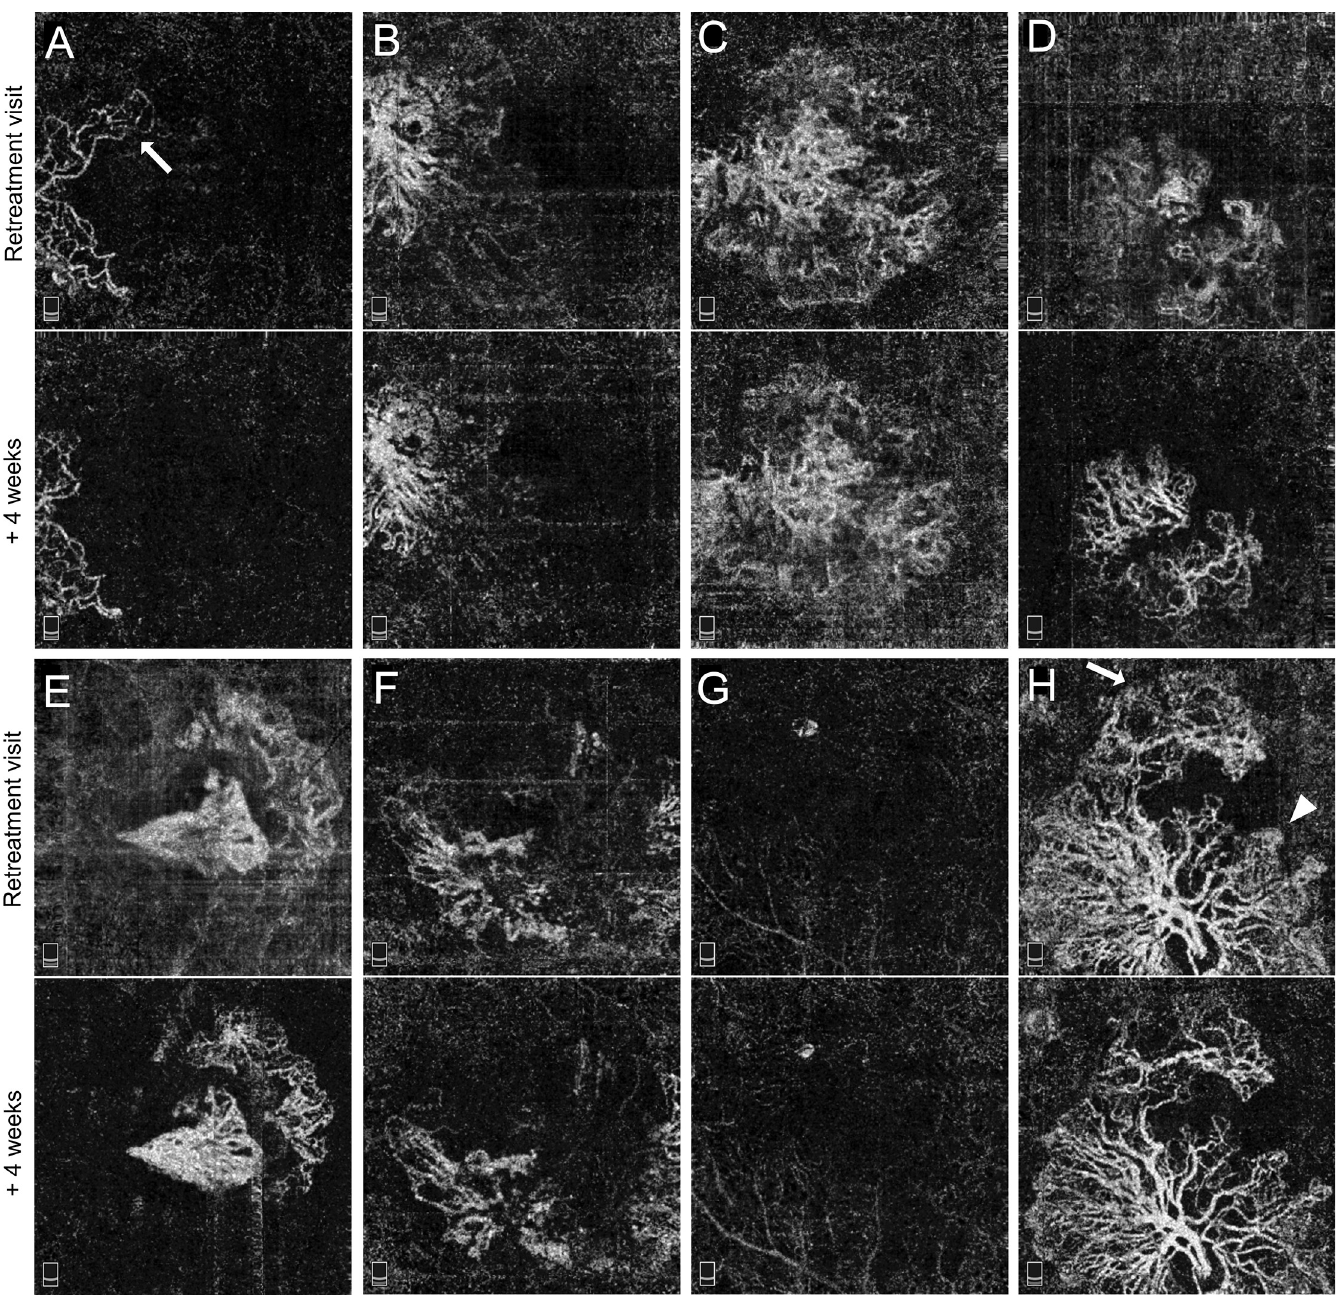
Fig 4. Comparison in choroidal neovascularization (CNV) appearance on OCT angiography (OCTA) (3 × 3 mm, outer retina slab) observed at retreatment visit and 4 weeks after the treatment in TEq7-12w group. A-H, Eight eyes with analyzable OCTA at both retreatment visit and 4 weeks after that visit. Some of the vascular components are only visible at retreatment visit (arrow), and a slight dilation of microvasculature is observed at retreatment visit. In two eyes ( A and C ), the location of CNV was graded as foveal involving due to the presence of pigment epithelial detachment with possible inactive fibrovascular components on B-scan crossing the foveal